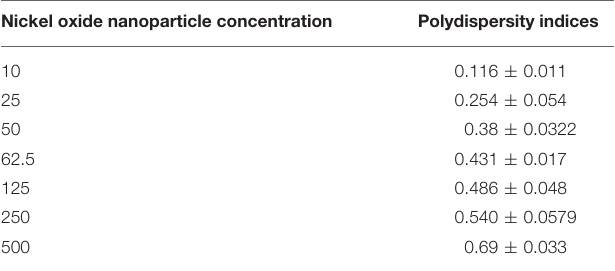
TABLE 1 | Polydispersity indices of NiO-NP in aqueous suspension through Dynamic Light Scattering (DLS) mechanism. Nickel oxide nanoparticle concentration Polydispersity indices